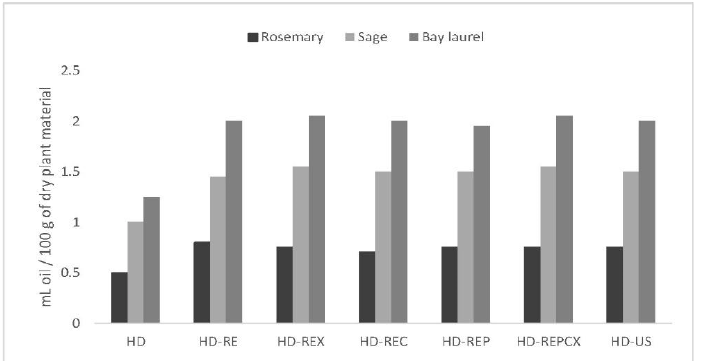
Figure 1. Effect of different hydrodistillation pretreatments on the extraction yield of rosemary, sage, and bay laurel essential oil. Hydrodistillation without pretreatment (negative control)—HD; hydrodistillation with reflux extraction pretreatment—HD-RE; hydrodistillation with reflux extraction pretreatment assisted with enzymes: xylanase—HD-REX; cellulase—HD-REC; pectinase—HD-REP; pectinase + cellulase + xylanase—HD-REPCX; hydrodistillation with ultrasonic pretreatment—HD-US.